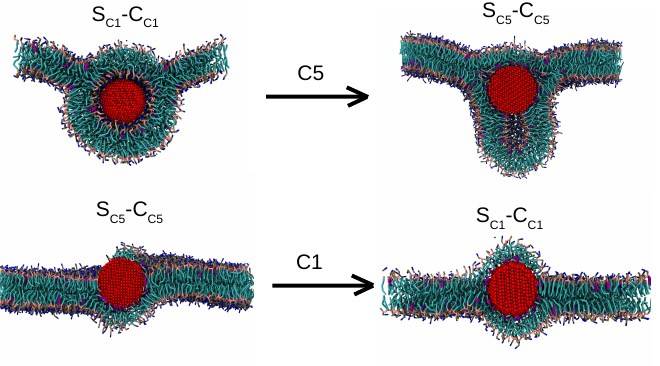
Figure 5. Simulation snapshots for 5 nm CG NPs showing the long-term effect of an instantaneous conversion of the NP representation in CGMD: from C C 1 -S C 1 to C C 5 -S C 5 (top) and from C C 5 -S C 5 to C C 1 -S C 1 (bottom). The structure at the end of an unbiased CGMD simulation for the original representation was used as on input for the alternative representation. As the nature of the lipids is not crucial at this stage, all the lipids are shown as blue sticks and cholesterol in pink sticks, while each CG bead in the Ag CG NP is represented by a red